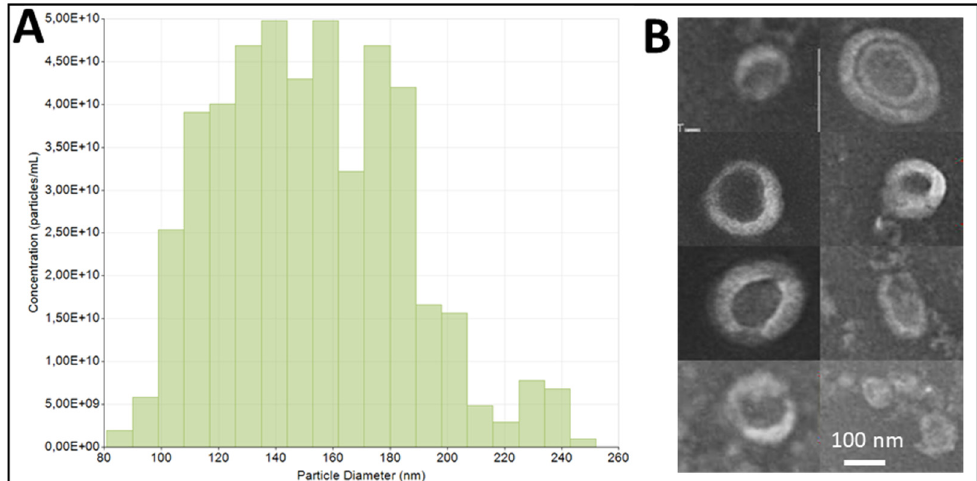
Figure 1. ADNVs size distribution. The graph ( A ) represents the size distribution and quantification of the APNP fraction, analyzed by tunable resistive pulse sensing (qNano). The average hydrodynamic diameter is 152 nm (St. Dev ± 32.3 nm), while the average concentration of three measurements is 4.78 × 10 11 . TEM images show ADNVs morphology and size ( B ).